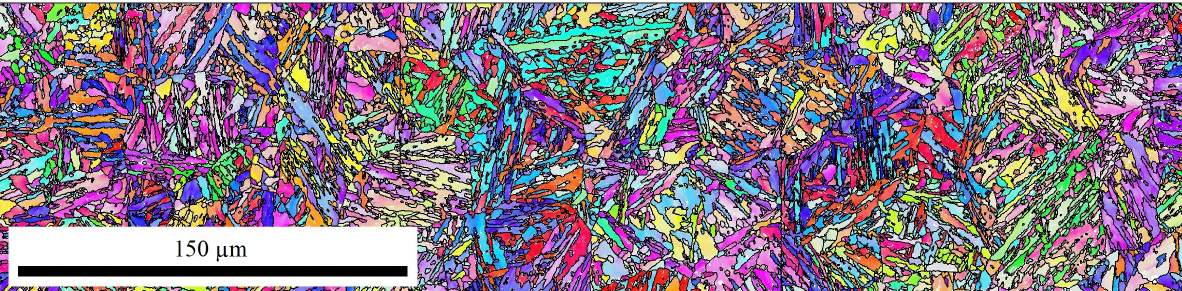
Figure 4. EBSD measurements — 0